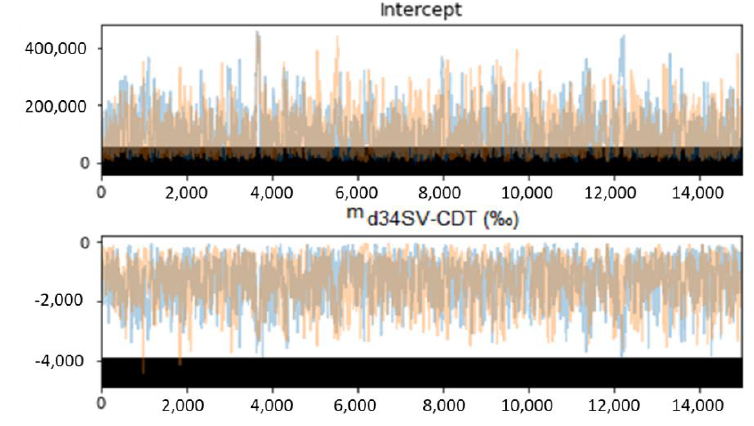
Figure 3. Posterior probability distributions of the proposed characterization model.